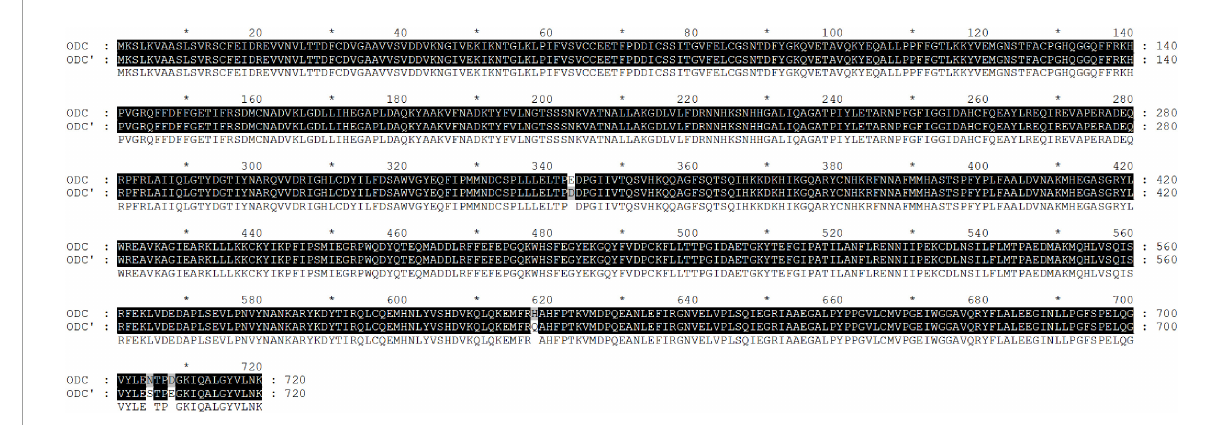
a statistically significant difference. Duncan’s test was used to evaluate the statistical significance of differences. OriginLab (Version 8.1; OriginLab Inc., Massachusetts, USA) and Adobe